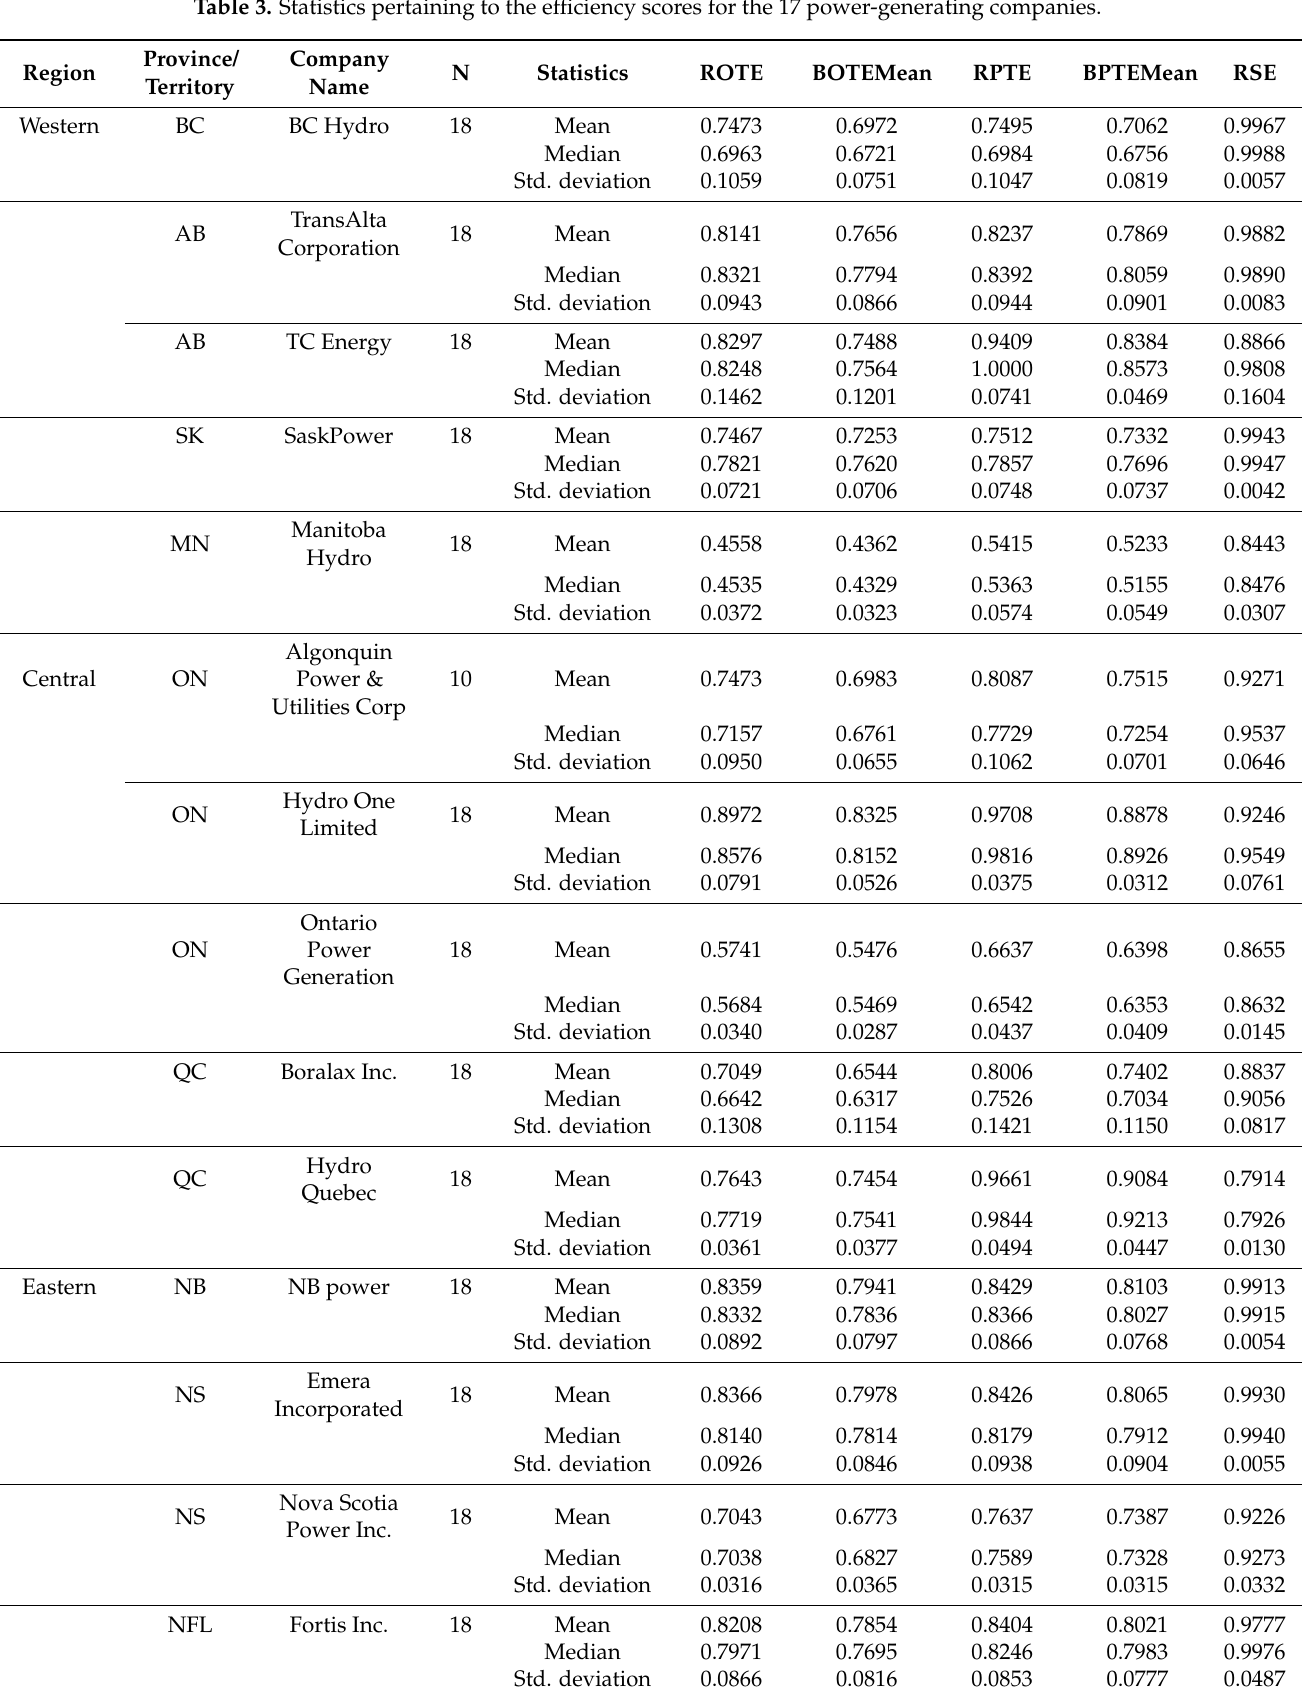
Table 3. Statistics pertaining to the efficiency scores for the 17 power-generating companies.